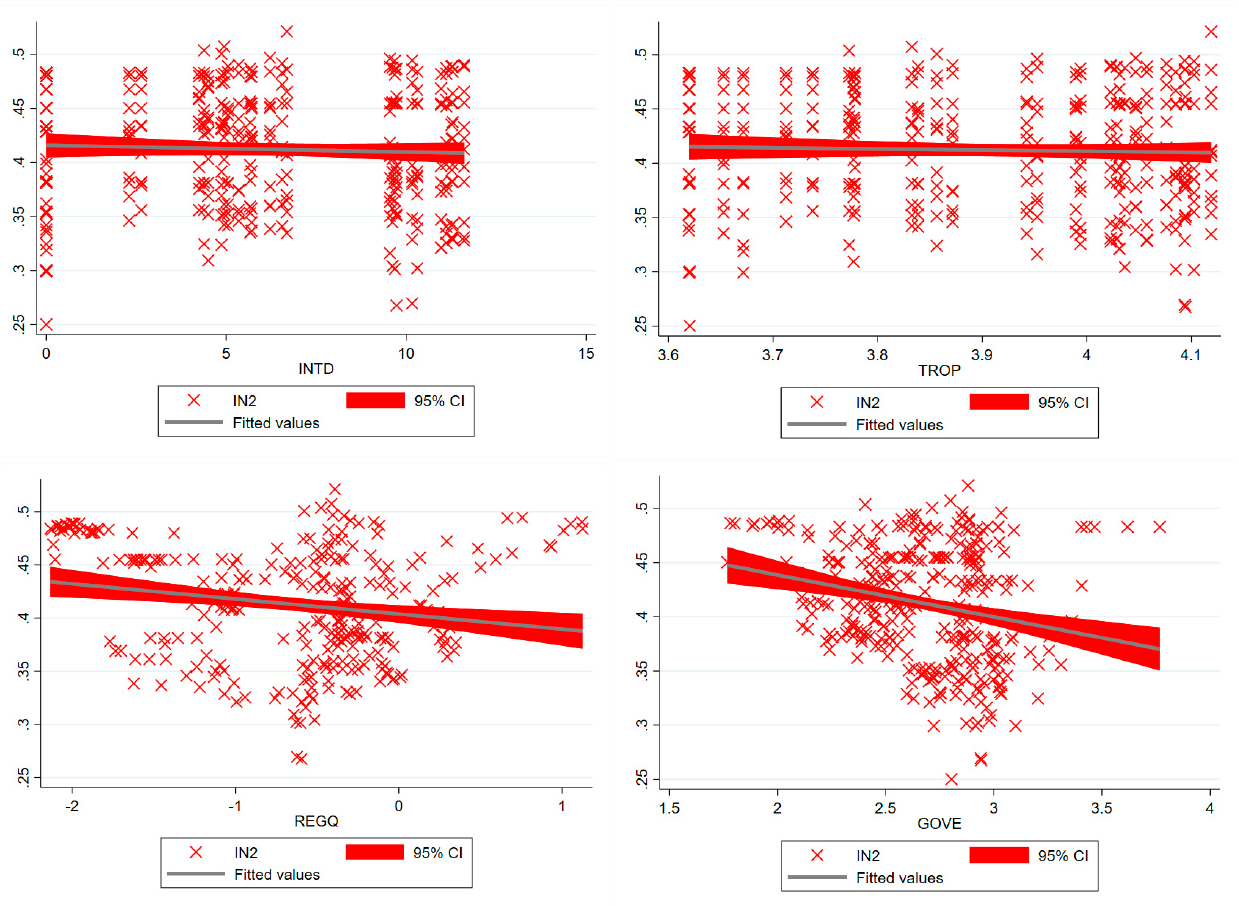
Figure 7. Fitted values for income inequality and globalization dynamics. Note: CI—Confidence interval. Legend: IN2—The income share of the top 10%, INTD—Global internet diffusions; TROP— Global trade